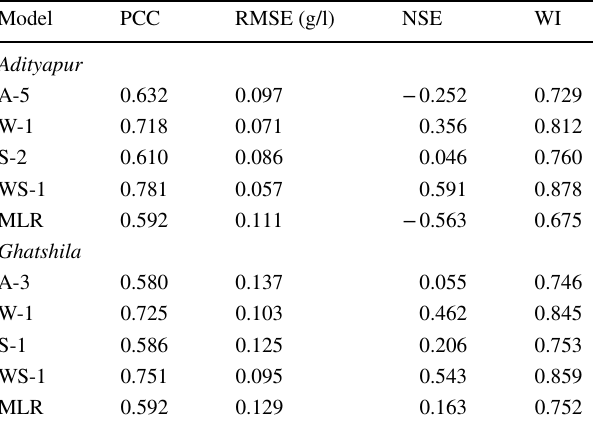
Table 7 Comparative results of models during testing for both sites